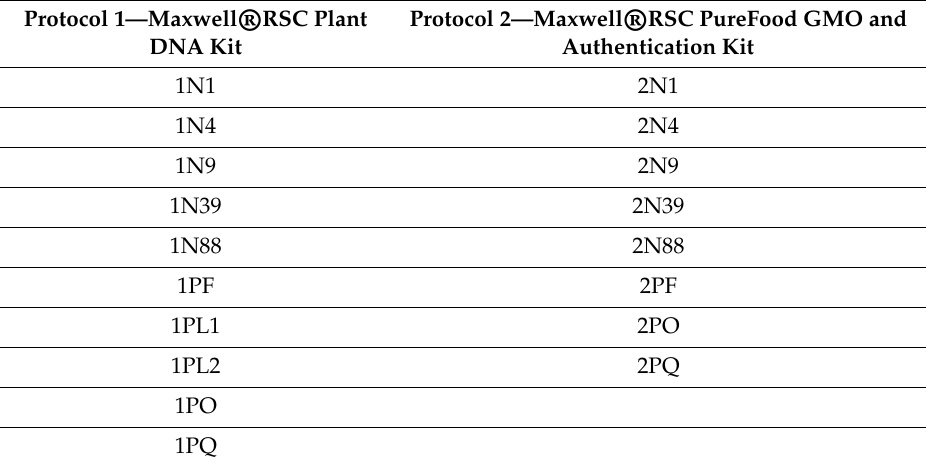
Table 2. List of samples used for the two DNA extraction